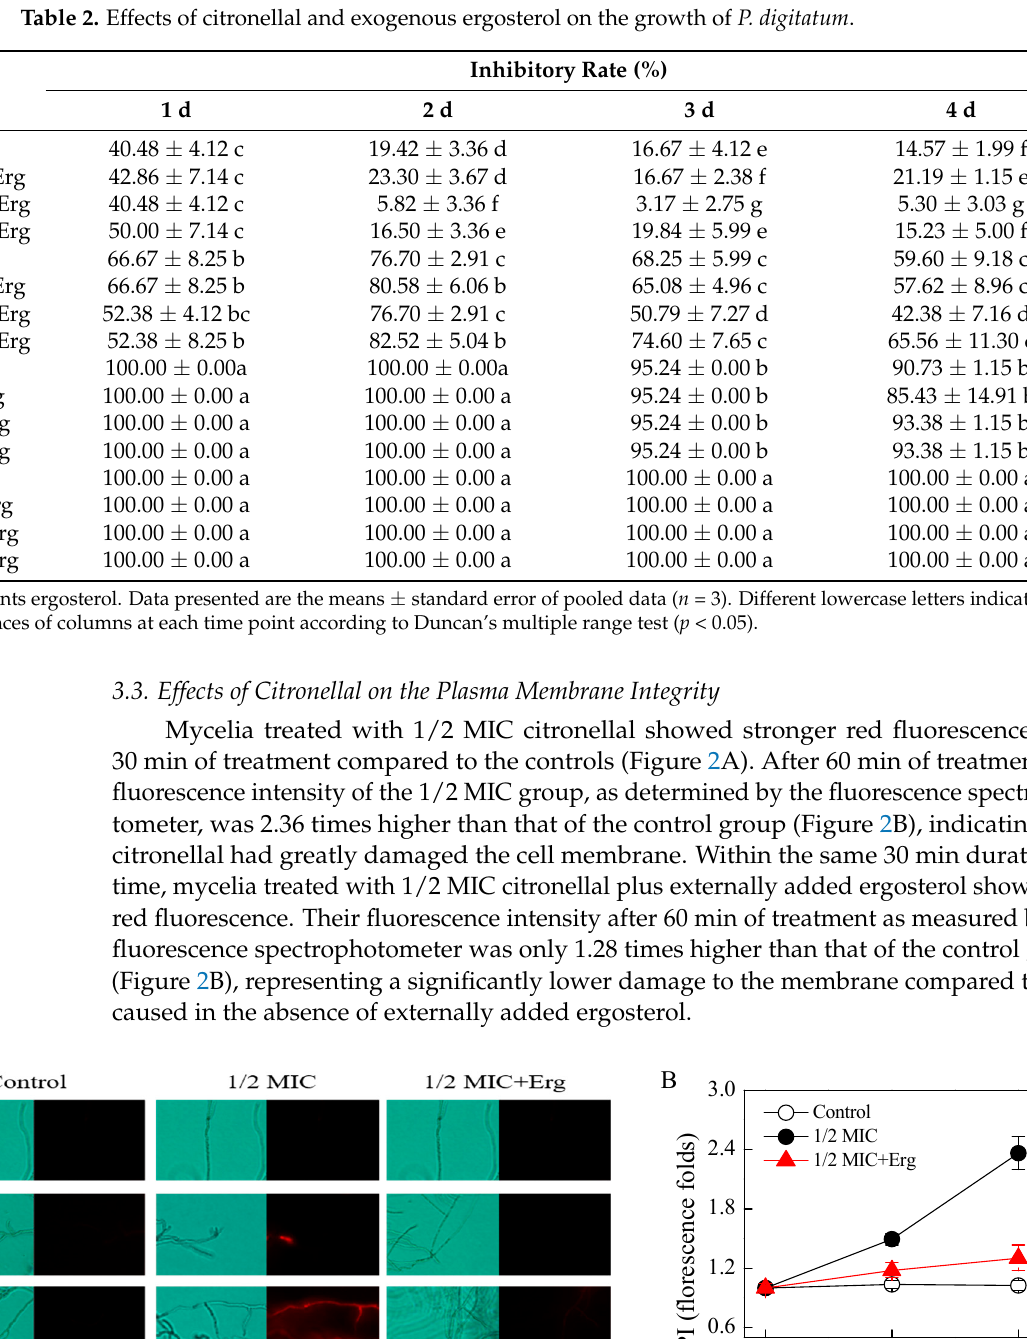
Table 2. Effects of citronellal and exogenous ergosterol on the growth of P. digitatum.